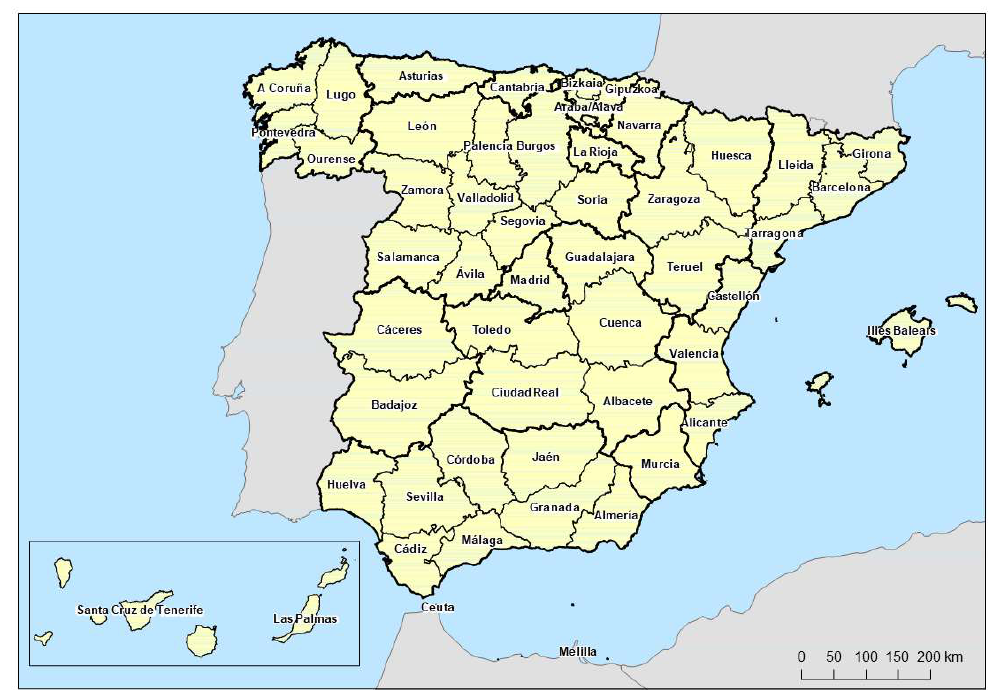
Figure 1. Political map of Spain.